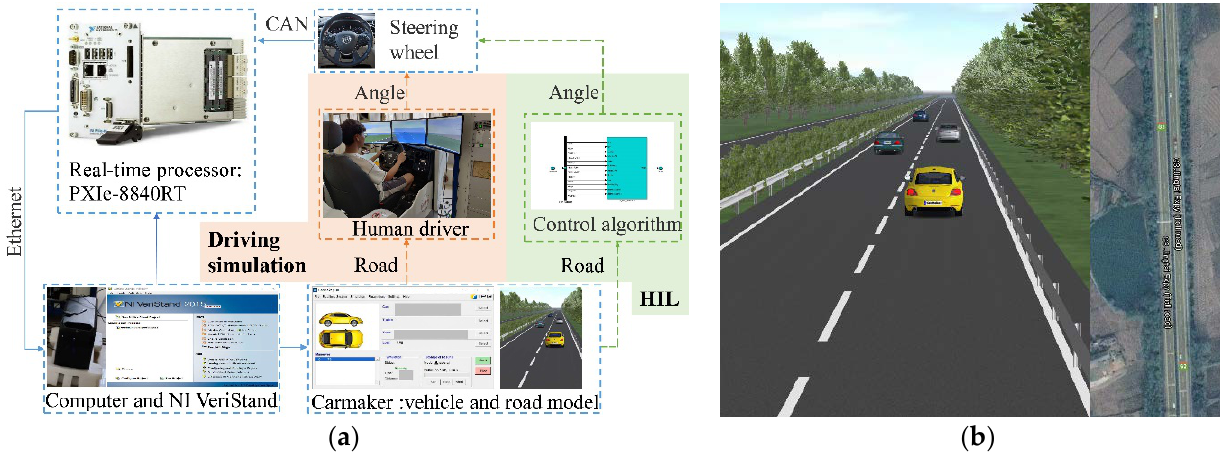
Figure 11. Experimental equipment framework and road modeling. ( a ) Driving simulation and HIL implementation . ( b ) Hefei-Xuzhou Section of G3 Jingtai Expressway in China in Carmaker.